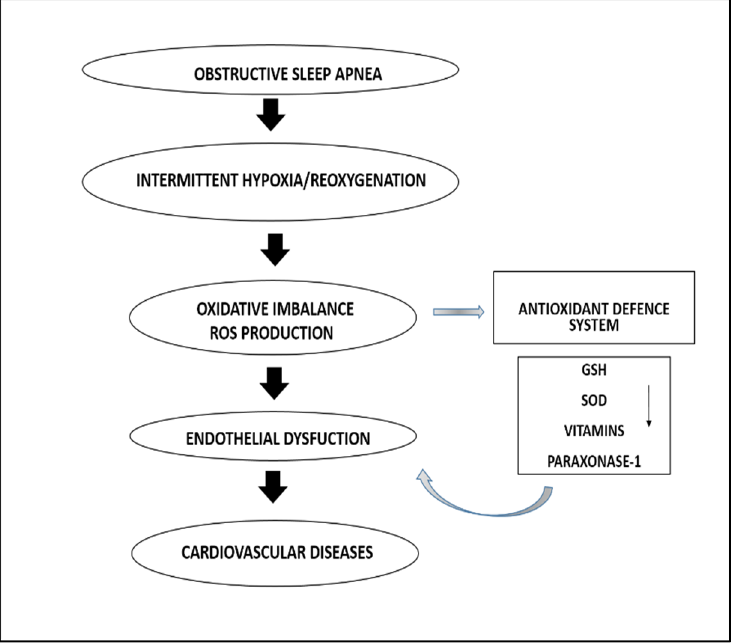
Figure 1. Flow chart describing the role of antioxidant defence molecules in the pathogenesis of OSA. GSH: glutatione; SOD: superoxide dismutase. GSH: glutatione; SOD: superoxide